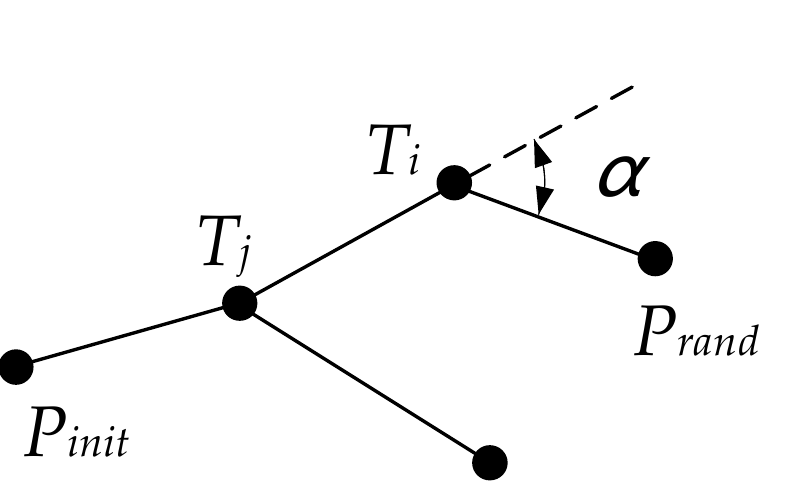
Figure 6. Nodes of the random tree. After obtaining the set T s , a more useful measurement function is introduced to select the tree node in the set T s . The value C p of the measurement function is the weighted sum of the distance cost D p (cid:48) and the angle cost A p (cid:48) . P near is determined as the adjacent tree node corresponding to the minimum value of C p . Equations (17)–(21) show how to calculate the cost of selecting P near